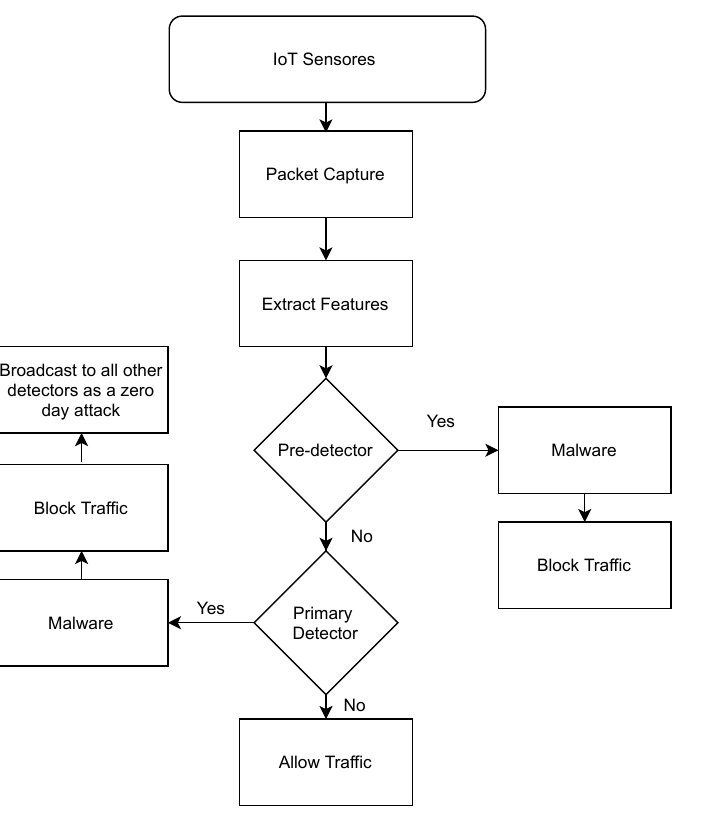
Figure 5. Workflow of CoLL-IoT Detection System. The first layer, the IoT layer, consists of all the IoT devices and sensors that are connected to the system. Therefore, all of the network traffic generated or received by the IoT devices in this layer will be analyzed by an intelligent system in the upper